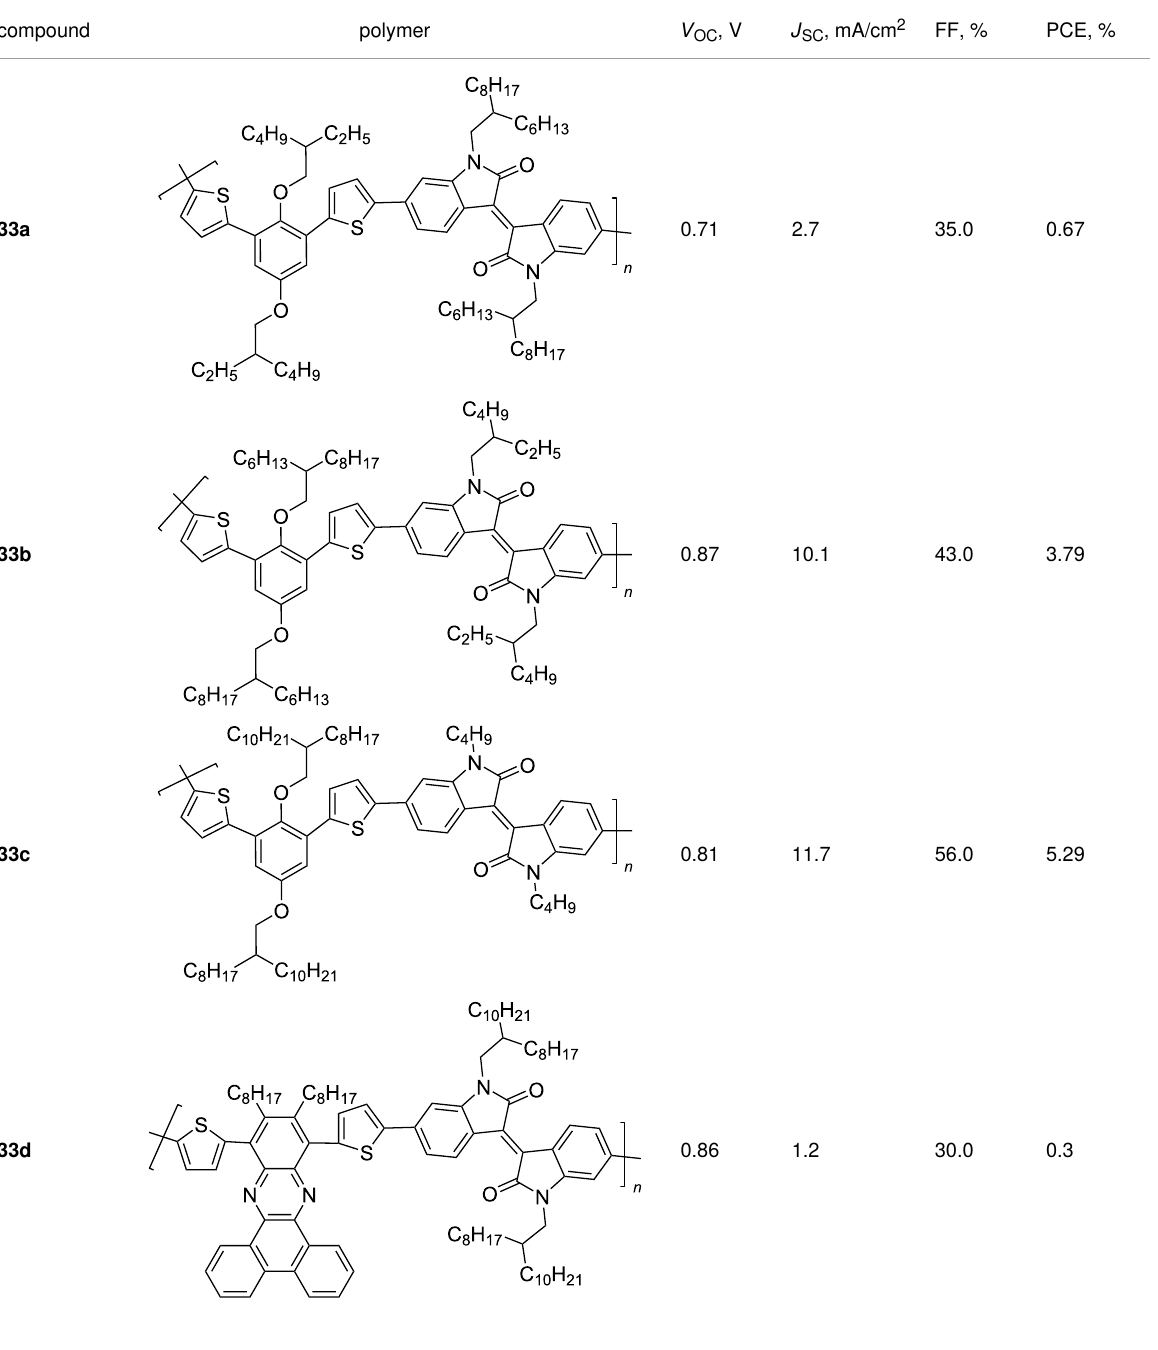
Table 6: Photovoltaic characteristics of OSCs based on aromatic embedded polymers 33 and 34